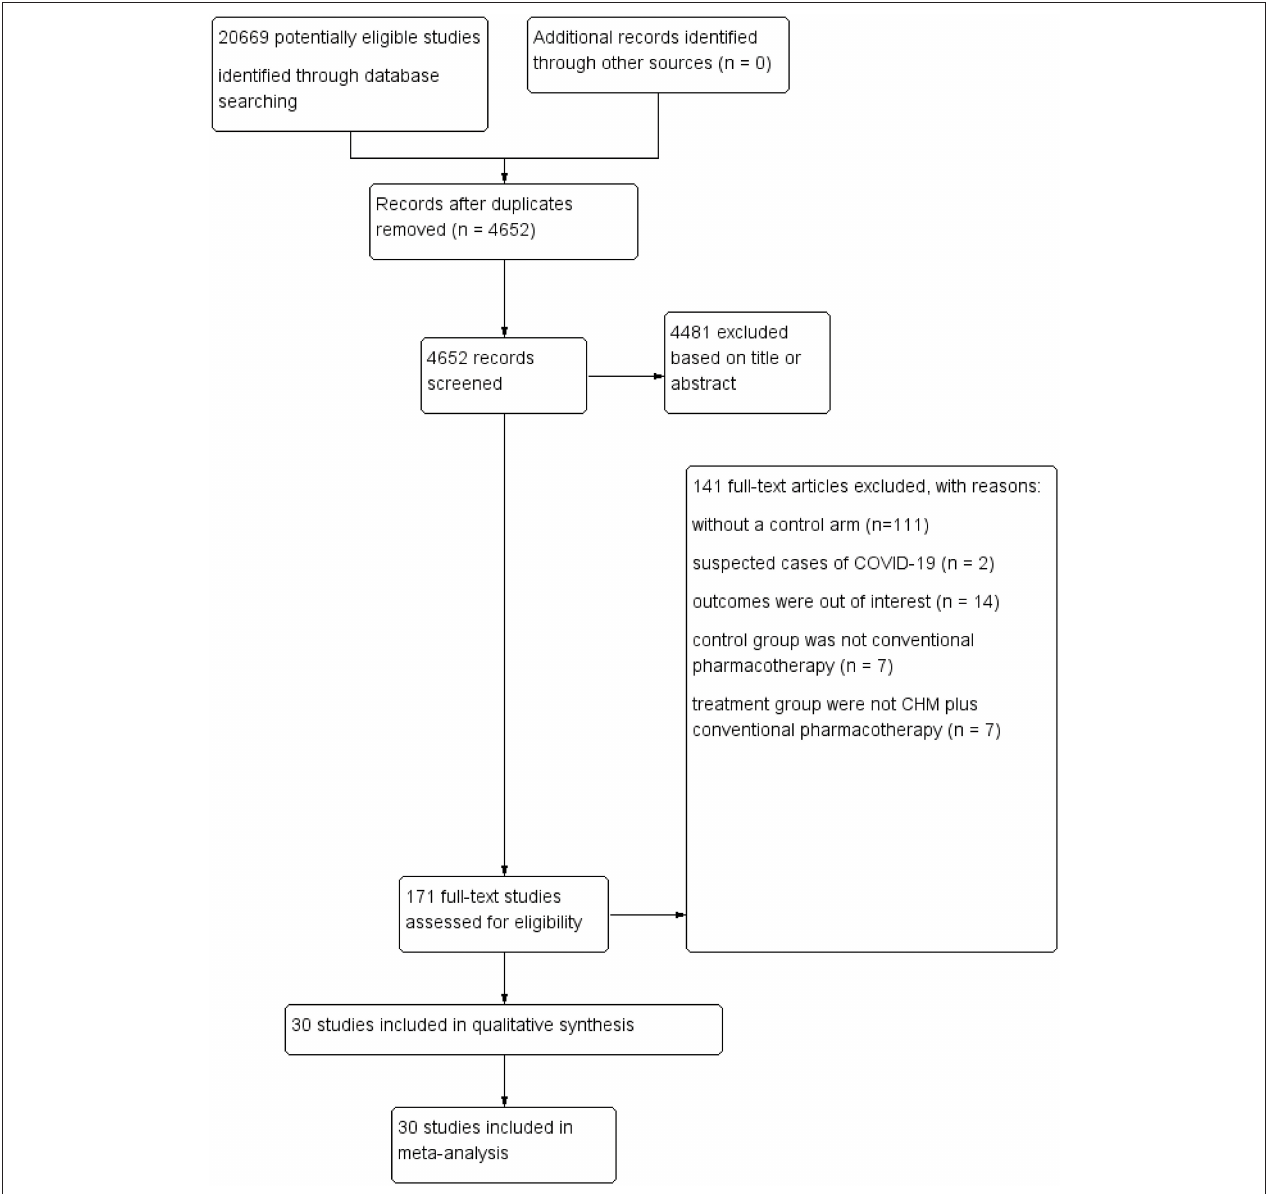
FIGURE 1 | Flow diagram of search and selection